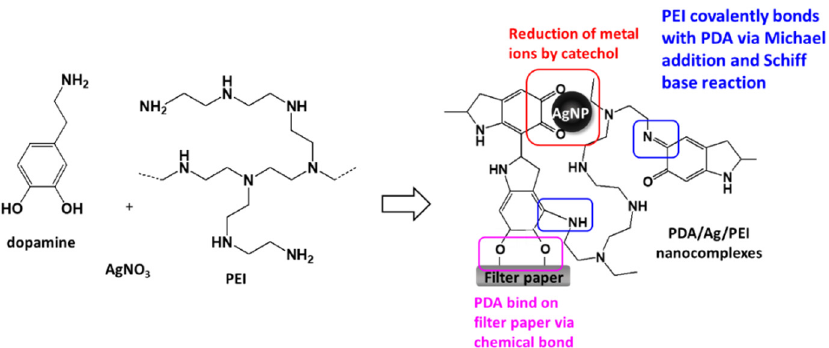
Figure 3. Schematic illustration and possible mechanism of the loading of PDA/PEI/Ag nanocom- plexes onto cellulose filter paper.